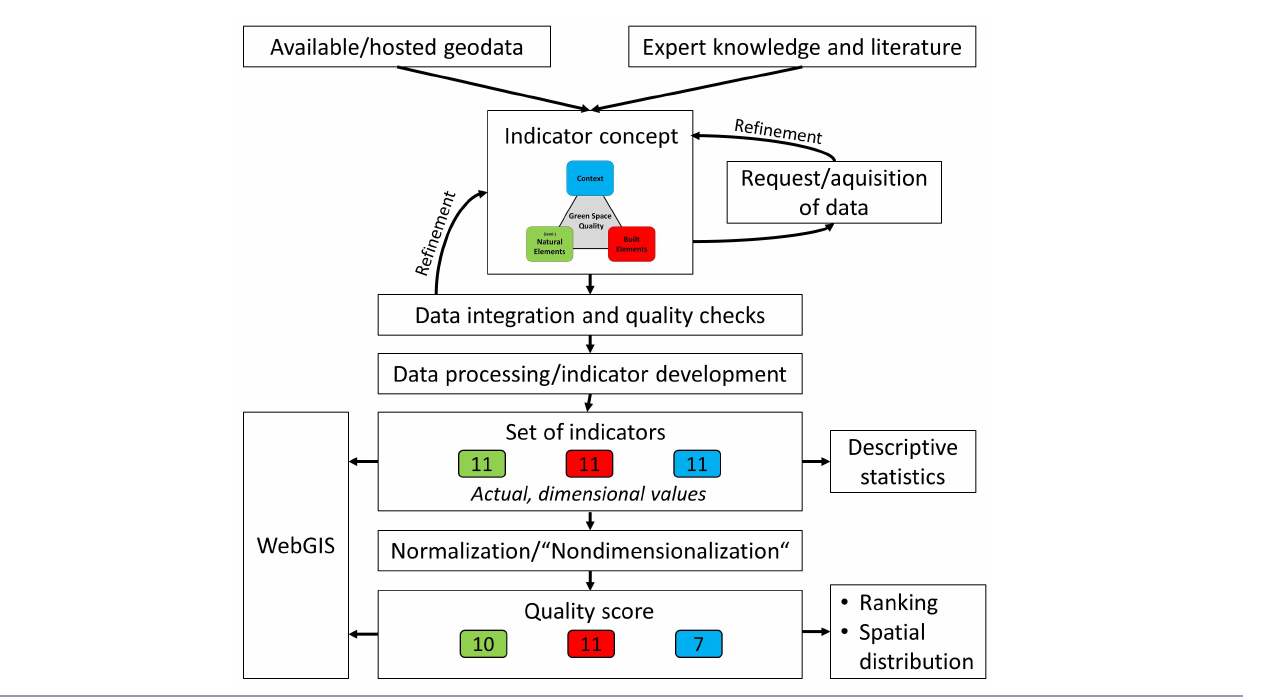
Fig. 3 . Workflow chart of the